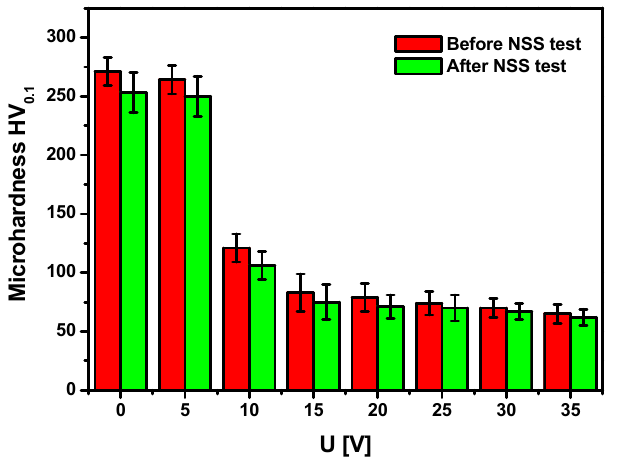
Figure 14. Microhardness of the Ti-13Zr-13Nb alloy surface before and after the NSS test according to ISO 9227:2017 [44] for non-anodized substrate (U = 0 V) and after anodizing at U of 5–35 V for 120 min.